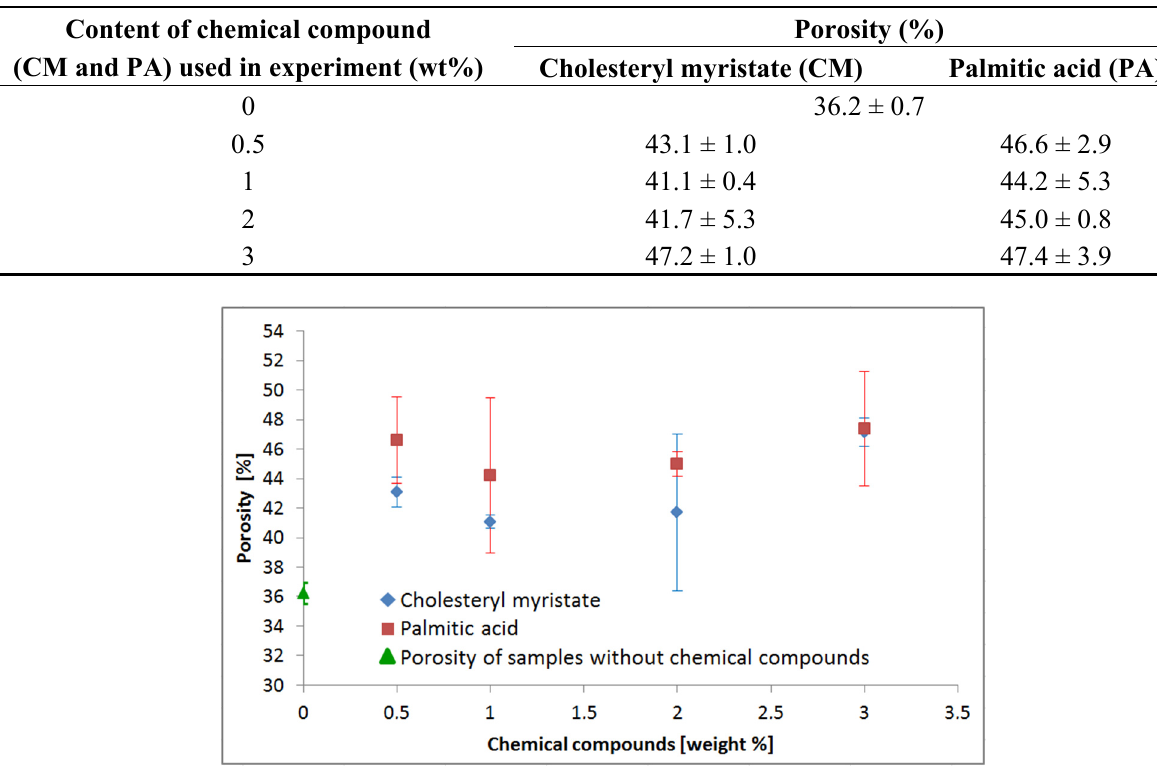
Figure 2. The exemplary of cross-sections of combustion-synthesized Fe-Al intermetallics ( a ); and microstructure of sinters: Fe–45Al ( b ); Fe–45Al–3 wt% PA ( c ); and Fe–45Al–3 wt% MC ( d ). Table 1. Porosity of obtained sinters.